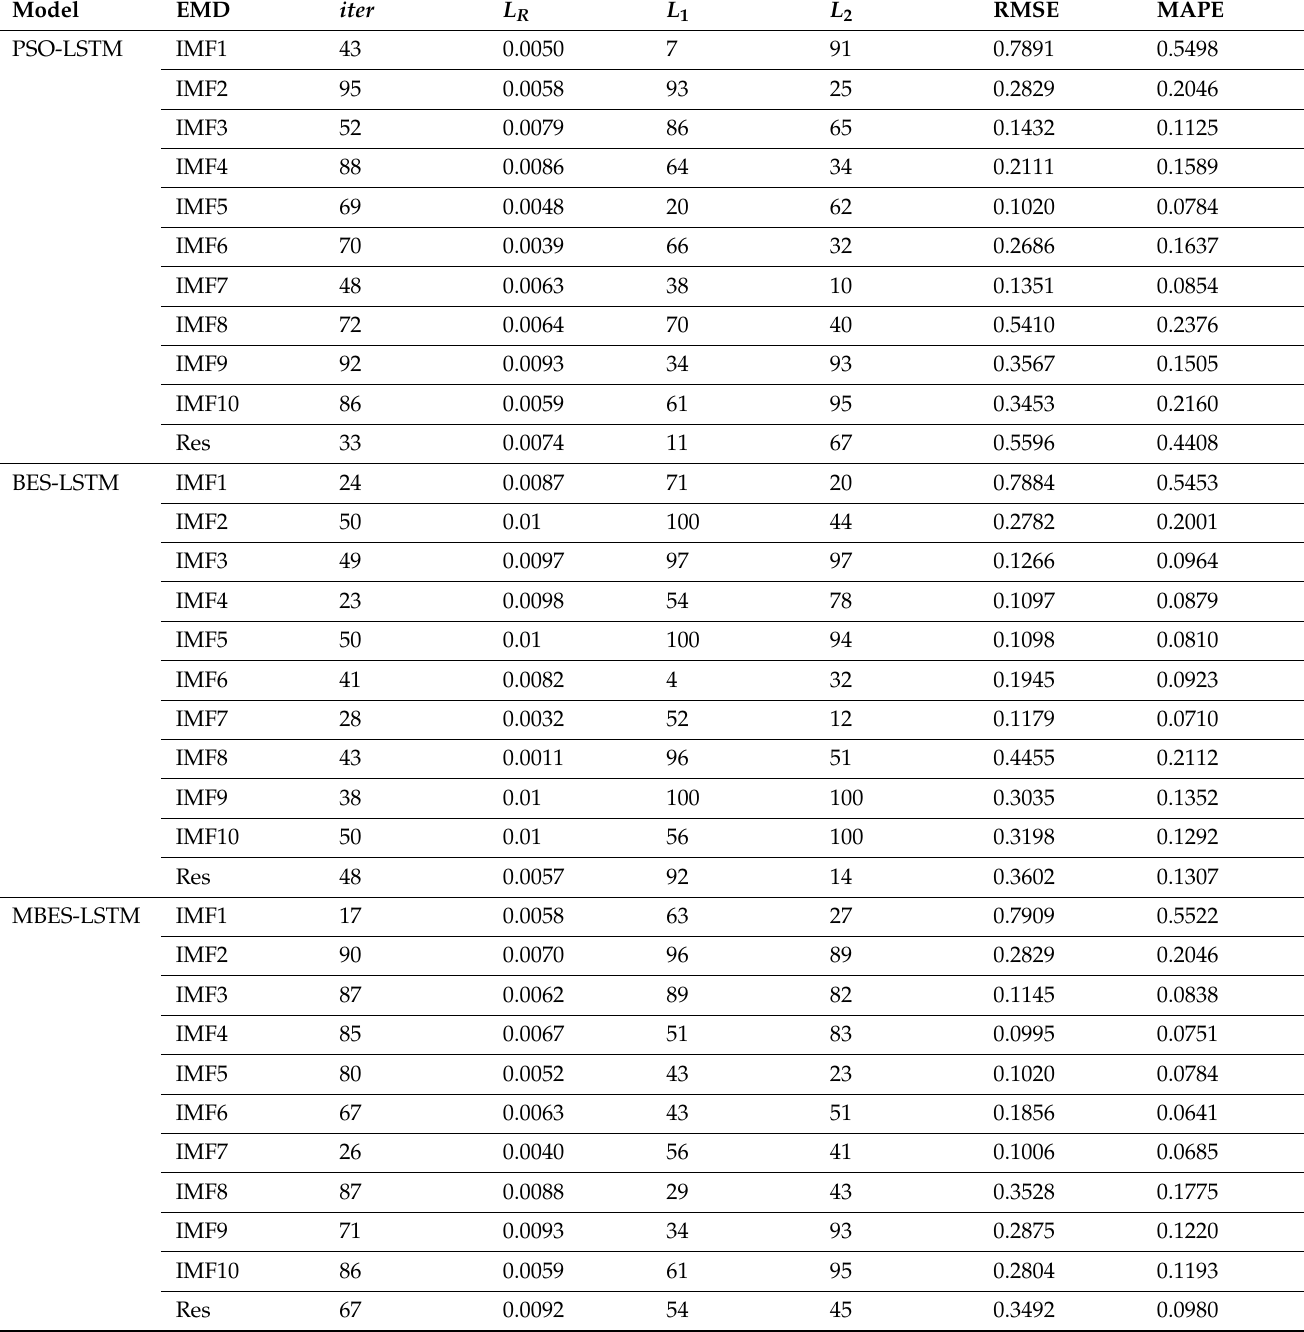
Table 8. The LSTM hyper-parameters value and errors based on PSO, BES, and